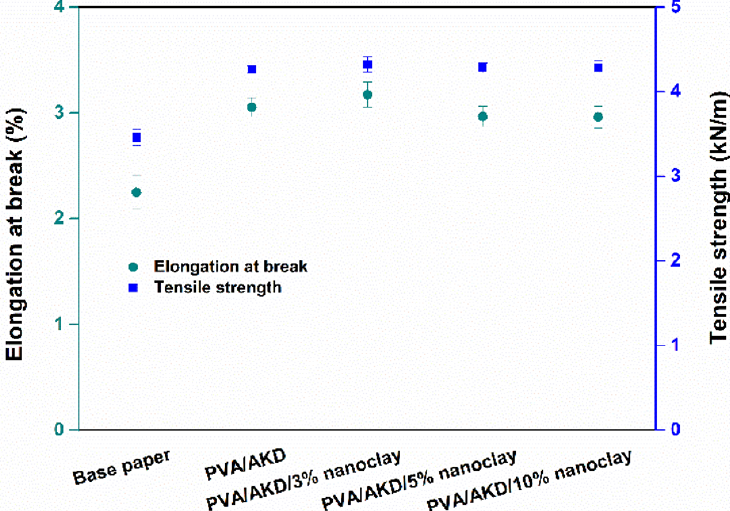
Figure 10. Elongations at break and tensile strengths of the base paper and coated